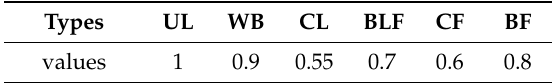
Table 3. The neighborhood weights for individual land-use